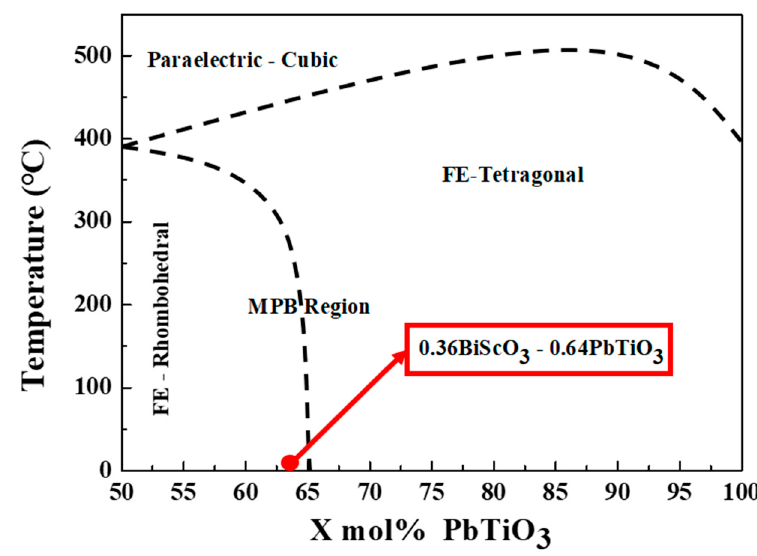
Figure 1. Phase diagram for the (1- x )(Bi,Sc)O 3 - x (Pb,Ti)O 3 perovskite system [3].